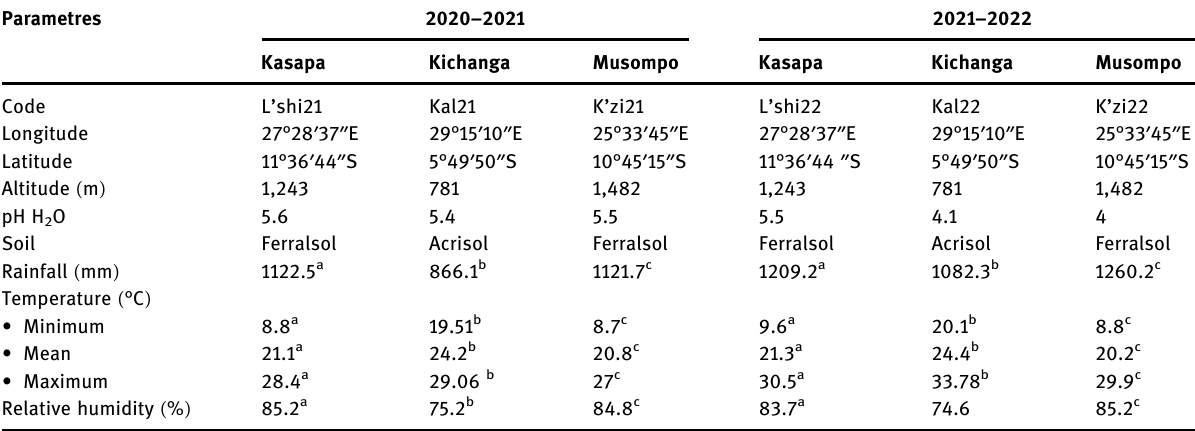
Table 1: Test environments characteristics